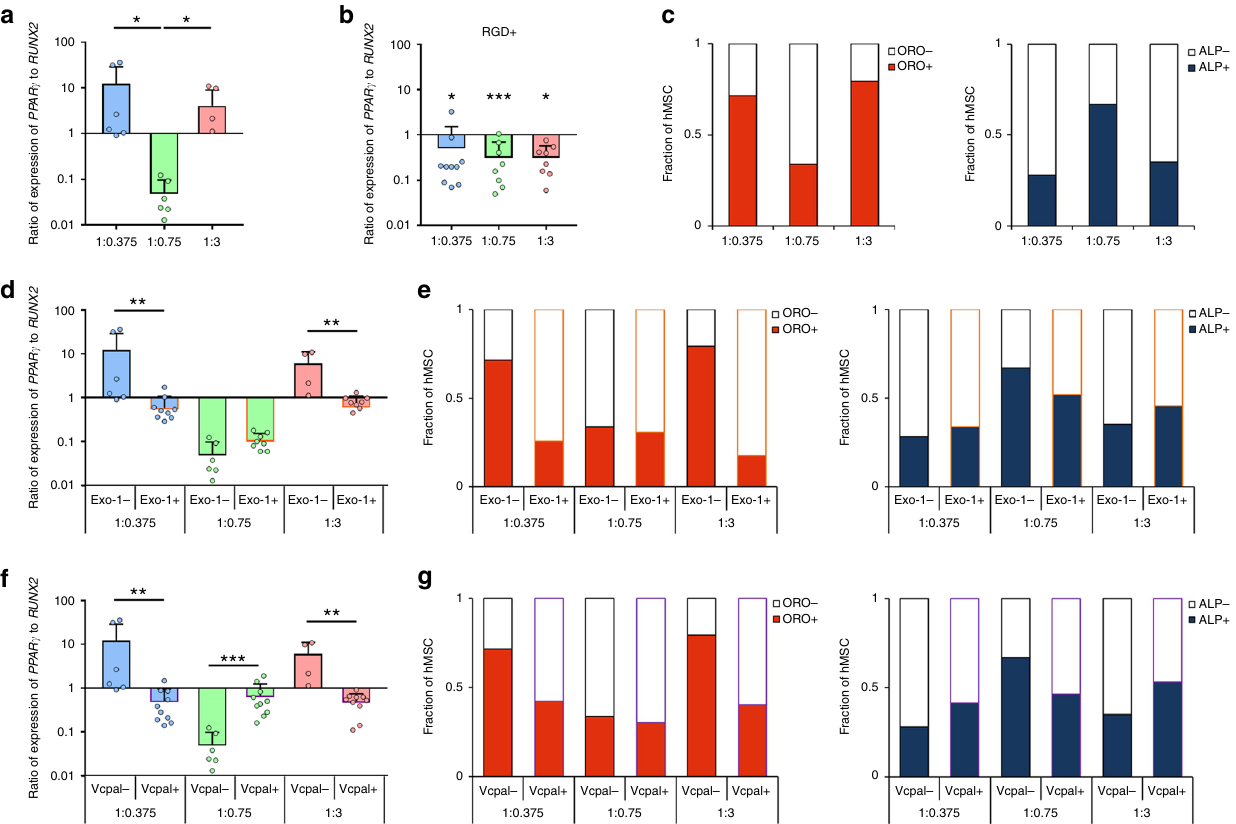
Fig. 3 hMSC ’ s modi fi cations to their pericellular environment directs fate. a Ratio of expression of PPAR γ to RUNX2 in hMSC encapsulated in hydrogels for 72 h and normalized to undifferentiated hMSC controls (mean + s.d.). Ratios were signi fi cantly higher in 1:0.375 and 1:3 (* p < 0.05) compared to 1:0.75 hydrogels ( n ≥ 4). b Ratio of expression of PPAR γ to RUNX2 in hMSC after treatment with RGD sequence-containing peptides (RGD + ) for 72 h (mean + s. d.). Ratios were not signi fi cantly different in hydrogels of different compositions ( n ≥ 8), but for each composition, expression was signi fi cantly different